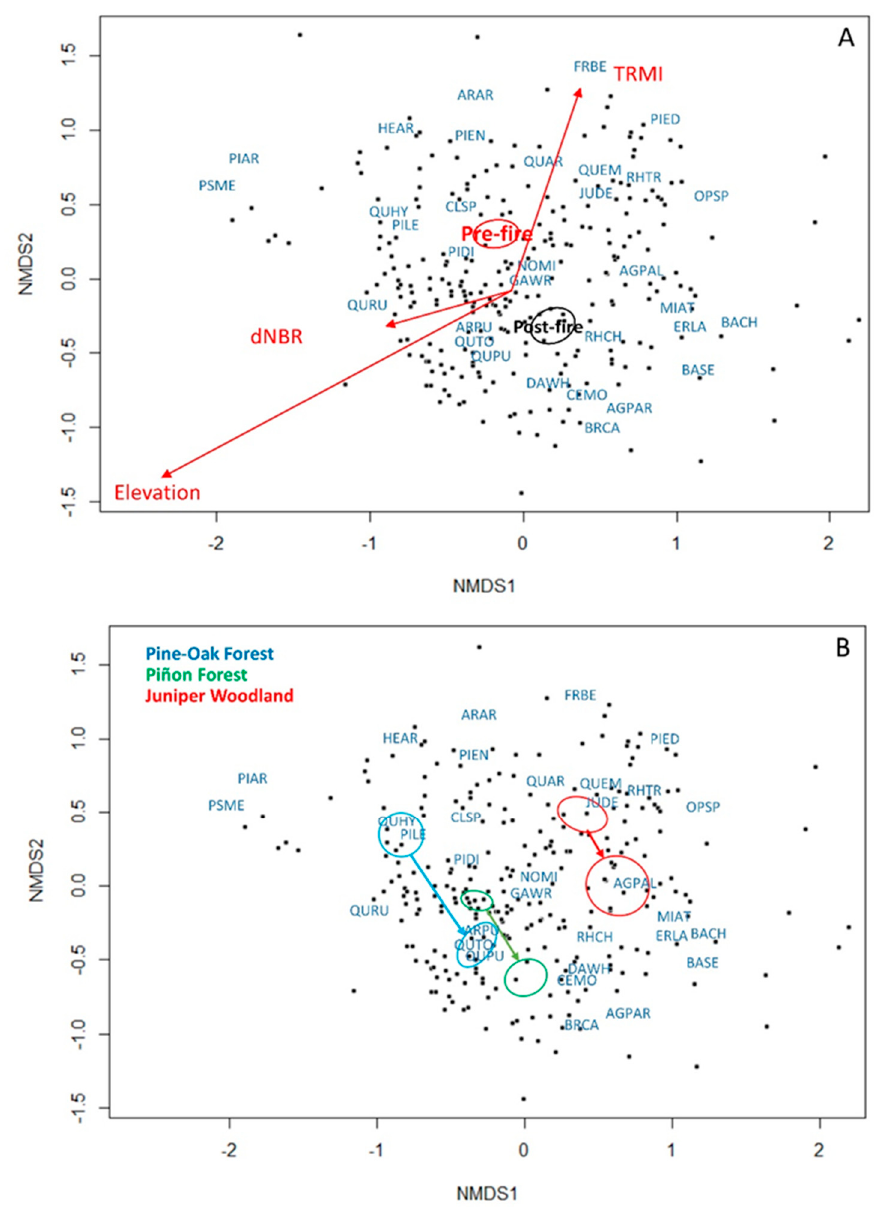
Figure 2. Nonmetric multidimensional scaling of 138 vegetation plots (black dots) in species space with pre- and post-fire vegetation types plotted with 95th percentile confidence ellipses around the centroid of each time-step. ( A ) Fire severity (dNBR), soil moisture (TRMI), and elevation are all significantly correlated with nMDS axes 1 and 2 ( p < 0.01); ( B ) nMDS plotted with 95th percentile confidence ellipses around the centroid of each vegetation type for each sampling interval. Pines were abundant in the pre-fire sampling interval but were largely killed by the fire. Post-fire transects are characterized by dominance by shrub and resprout oak taxa. Species acronyms are identified in Table 1. Table 2. Pearson correlations of species abundance and environmental variables with plot scores for nMDS axes for veg- etation transects and environmental variables. Significant species correlations are indicated with asterisks (* = p > 0.05, **= p > 0.01, ***= p > 0.001).